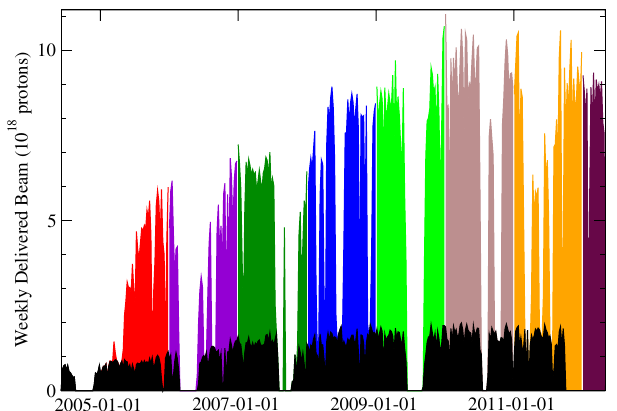
FIG. 15. Weekly Summary of Protons Accelerated in Main Injector for delivery to the pbar and NuMI targets. This stacked bar chart shows pbar weekly beam in black bars with colored bars indicating the NuMI weekly beam (each year a new color) so the top of the bar indicates the total weekly delivered 120 GeV